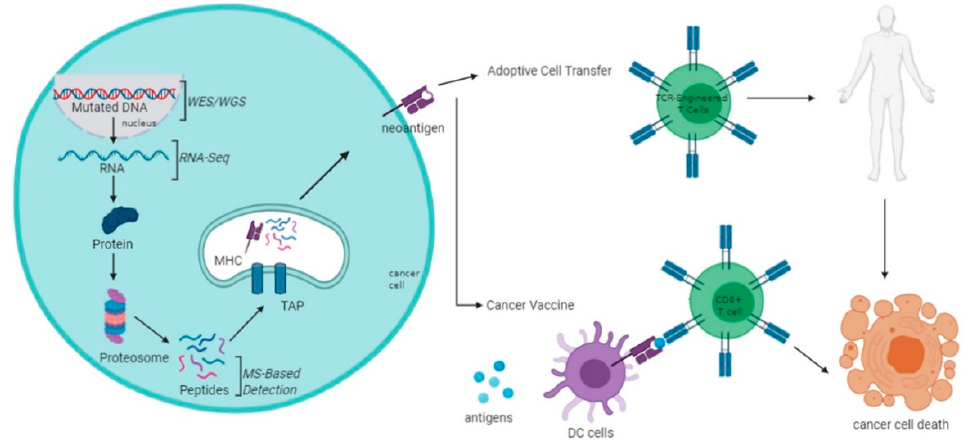
Figure 2. Brief schematic overview of neoantigen production and prediction and application through adoptive T cell therapies (ACT) and vaccination.